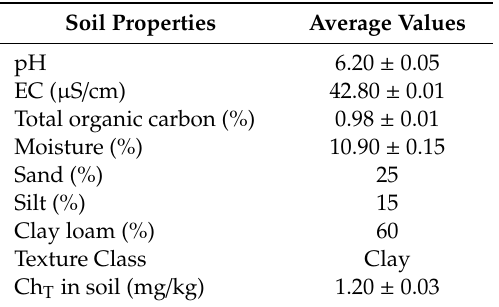
Table 1. Physicochemical properties of experimental soil.